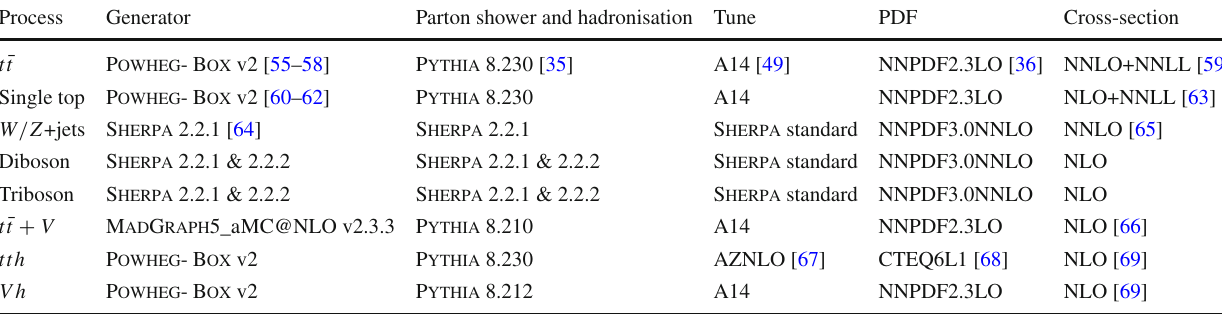
Table 1 Overview of MC generators used for different simulated event samples Process Generator Parton shower and hadronisation